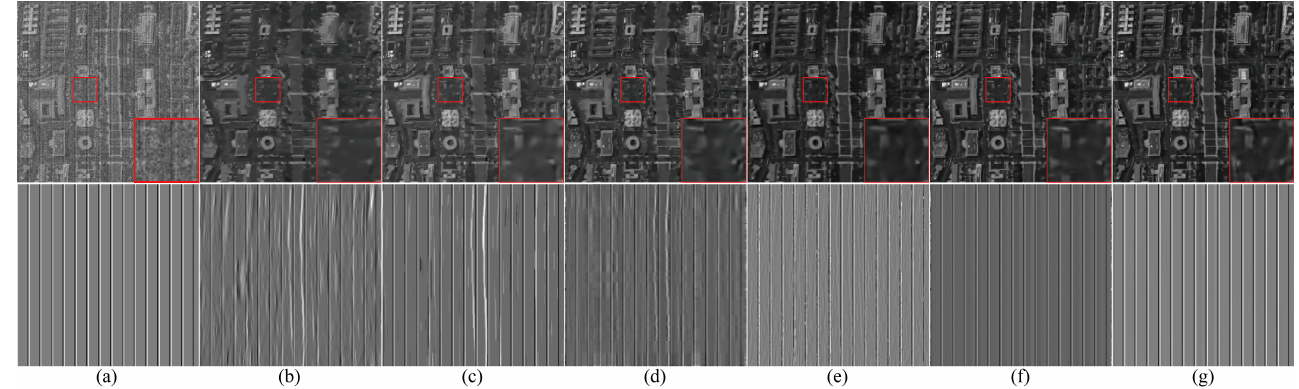
Figure 9. Visual comparisons on the SWDCM image in Figure 5g. Where noise level σ = 25, the pro- portion P and the intensity I of the periodical stripe are respectively 0.1 and 50. ( a ) Upper: Degraded SWDCM image. Down: Ground-truth stripe. ( b – g ) Estimated images and stripes respectively produced by the UTVSR, WNNM-WDSUV, HSI-DeNet, UV-DCNN, JAWS, and proposed